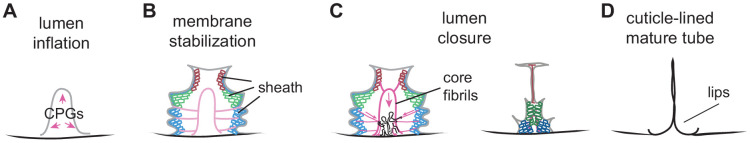
Model for aECM-dependent shaping of the vulva lumen during morphogenesis.(A) The vulva lumen is initially expanded by chondroitin proteoglycans (pink arrows). Black; cuticle. Gray; apical membrane. (B) A membrane-proximal aECM appears alongside matrix fibrils and a central core to halt and/or stabilize vulva expansion. vulE/F aECM; red. vulC/D aECM; green. vulA/B aECM; blue. (C) The lumen narrows in the anterior-posterior axis. We propose that the central core and fibrils attach to the aECM and underlying membranes and pull ventrally, anteriorly, and posteriorly to shape the vulva lumen. The aECM changes over time; transient components turn over and the membrane-proximal matrix develops cuticle-like features. (D) By adulthood, the lumen narrows into a slit and is lined by cuticle.